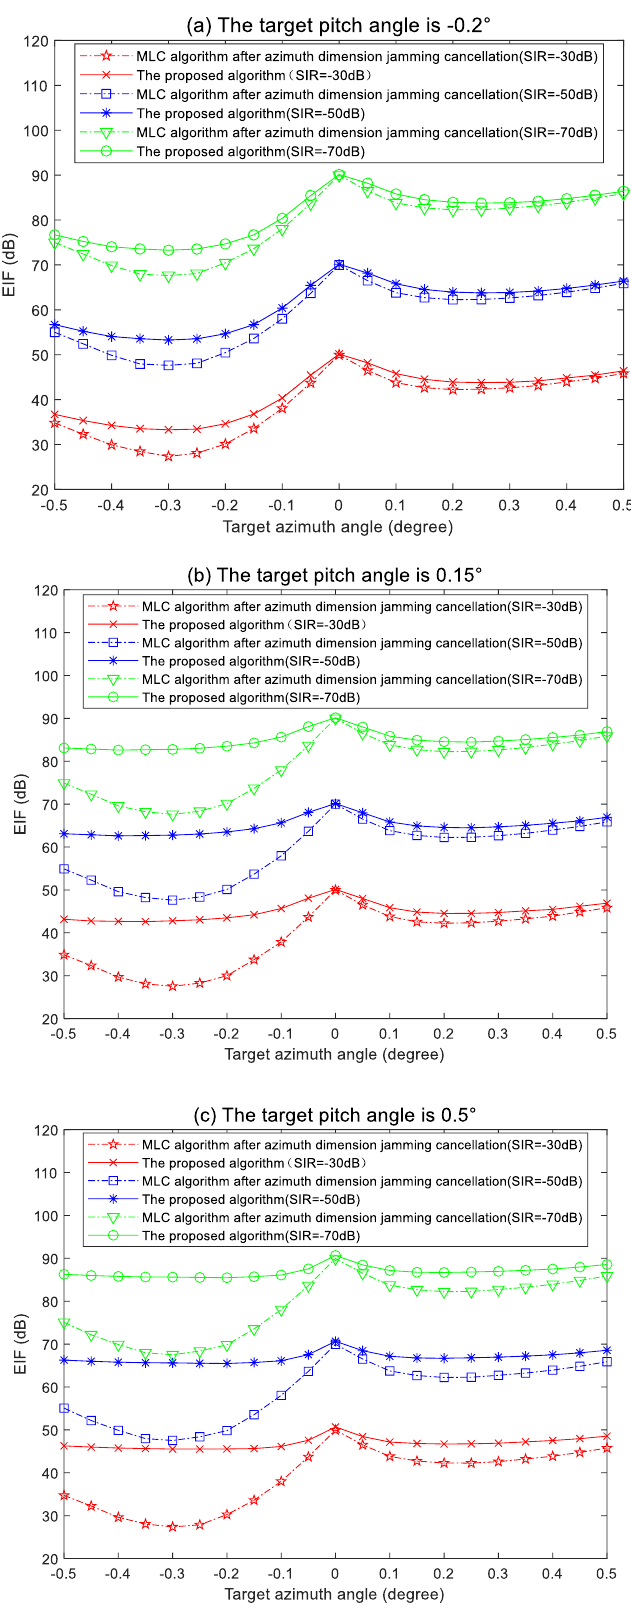
Figure 4. The EIFs of the two algorithms.